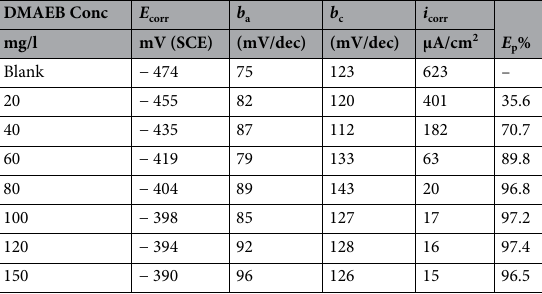
Table 2. Electrochemical parameters obtained from polarization curves of N80 C-steel pipe in 15.0% HCl solution without (blank) and with DMAEB at 303 K.